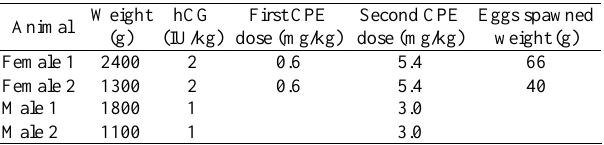
Table 1. Protocol of Steindachneridion parahybae induced